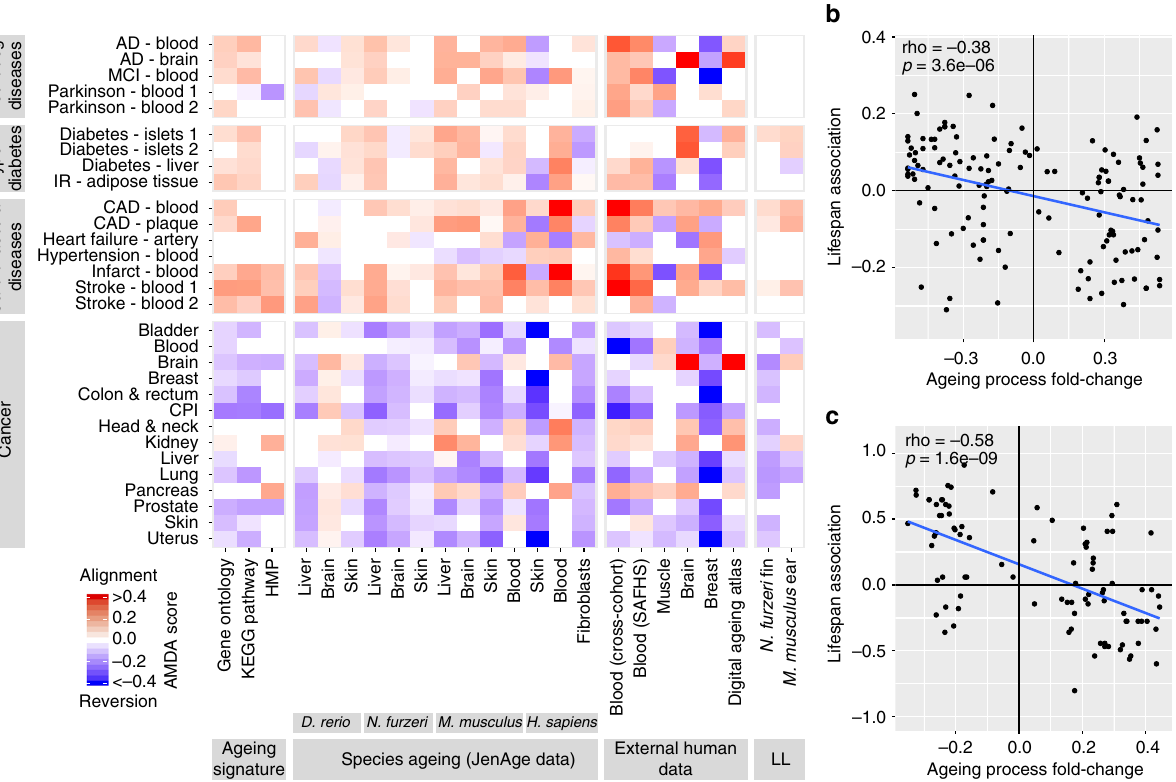
Fig. 3 Association of ageing-associated gene expression changes with ageing diseases and lifespan. a Ageing-mediated disease alignment scores (AMDA scores) for different ageing ( x axis) and disease data sets ( y axis). Abbreviations: AD Alzheimer ’ s disease, CAD coronary artery disease, CPI cancer proliferation index, cross-cohort cross-cohort study of blood ageing, HMP human metabolic pathways, IR insulin resistance, LL longitudinal ageing data, MCI mild cognitive impairment; SAFHS, San Antonio Family Heart Study. b , c Correlations between activity changes of processes during ageing ( x axis) and their lifespan-associations ( y axis, Pearson correlation) for N. furzeri ( b ) and mouse ( c ). The corresponding test statistics are provided in Supplementary Data